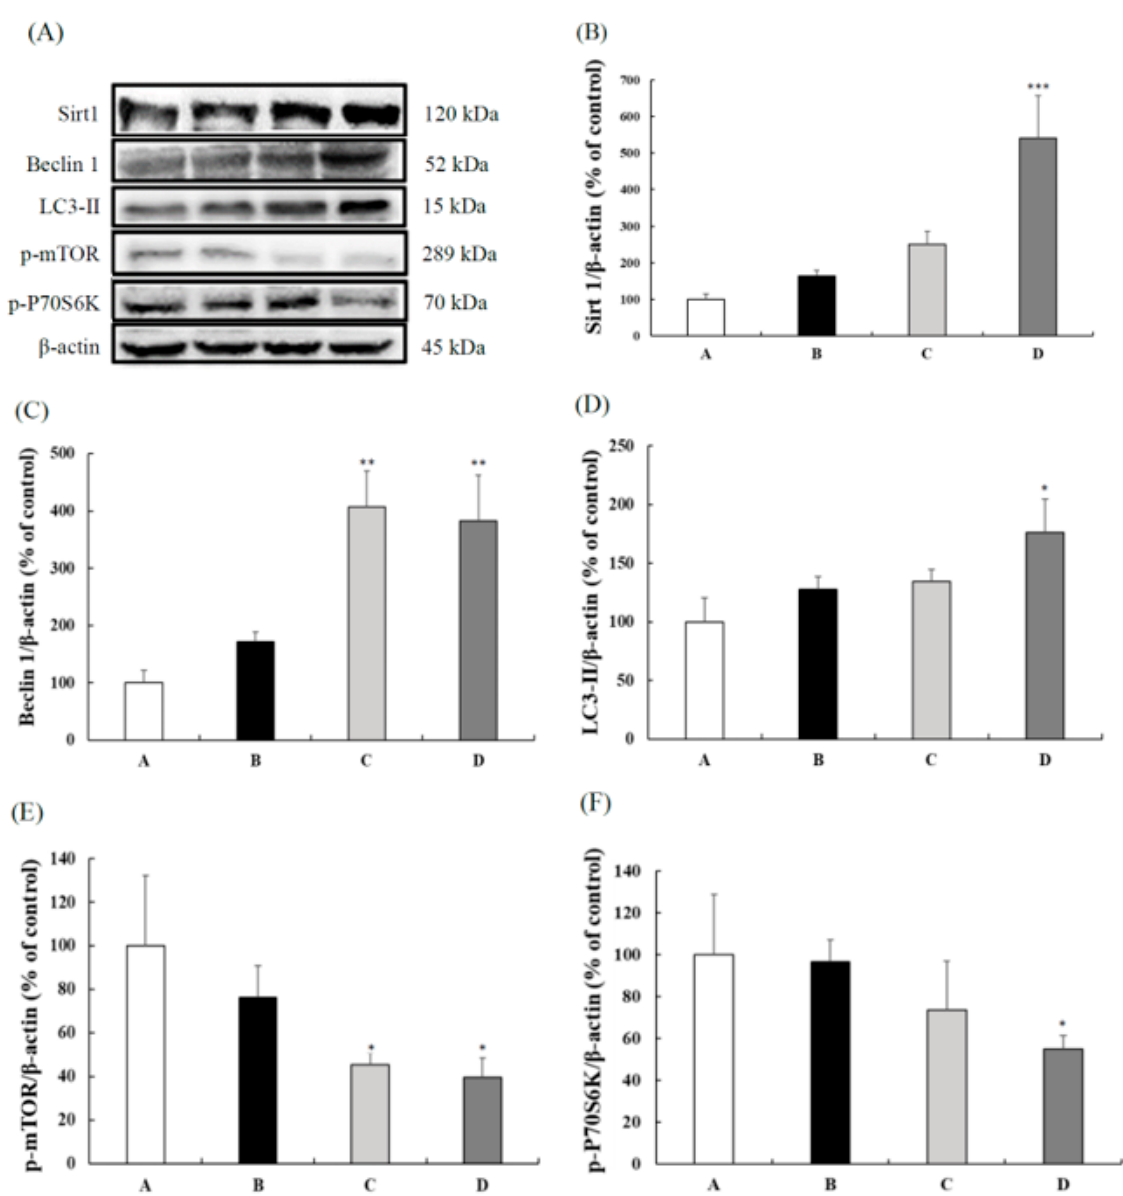
Figure 3. Protein expressions in the livers of 3-month-old male SAMP8 mice fed with different diets for 12 weeks. ( A ) The gel picture of Sirt 1, Beclin 1, LC3-II, p-mTOR, p-P70S6K, and β -actin expressions. ( B ) Sirt 1, ( C ) Beclin 1, ( D ) LC3-II, ( E ) p-mTOR, and ( F ) p-P70S6K protein expression in the livers of different groups. The y axis quantified by the western blot analysis protein of Sirt 1/ β -actin, Beclin 1/ β -actin, LC3-II/ β -actin, p-mTOR/ β -actin, and p-P70S6K/ β -actin are expressed as the percentage of control. Values are displayed as mean ± S.E.M. and were analyzed by one-way ANOVA ( n = 6/group). * p < 0.05, ** p < 0.005, *** p < 0.001 compared to the control group. A = SAMP8 control, B = 50 mg/kg BW/day CB, C = 100 mg/kg BW/day CB, D = 200 mg/kg BW/day CB.